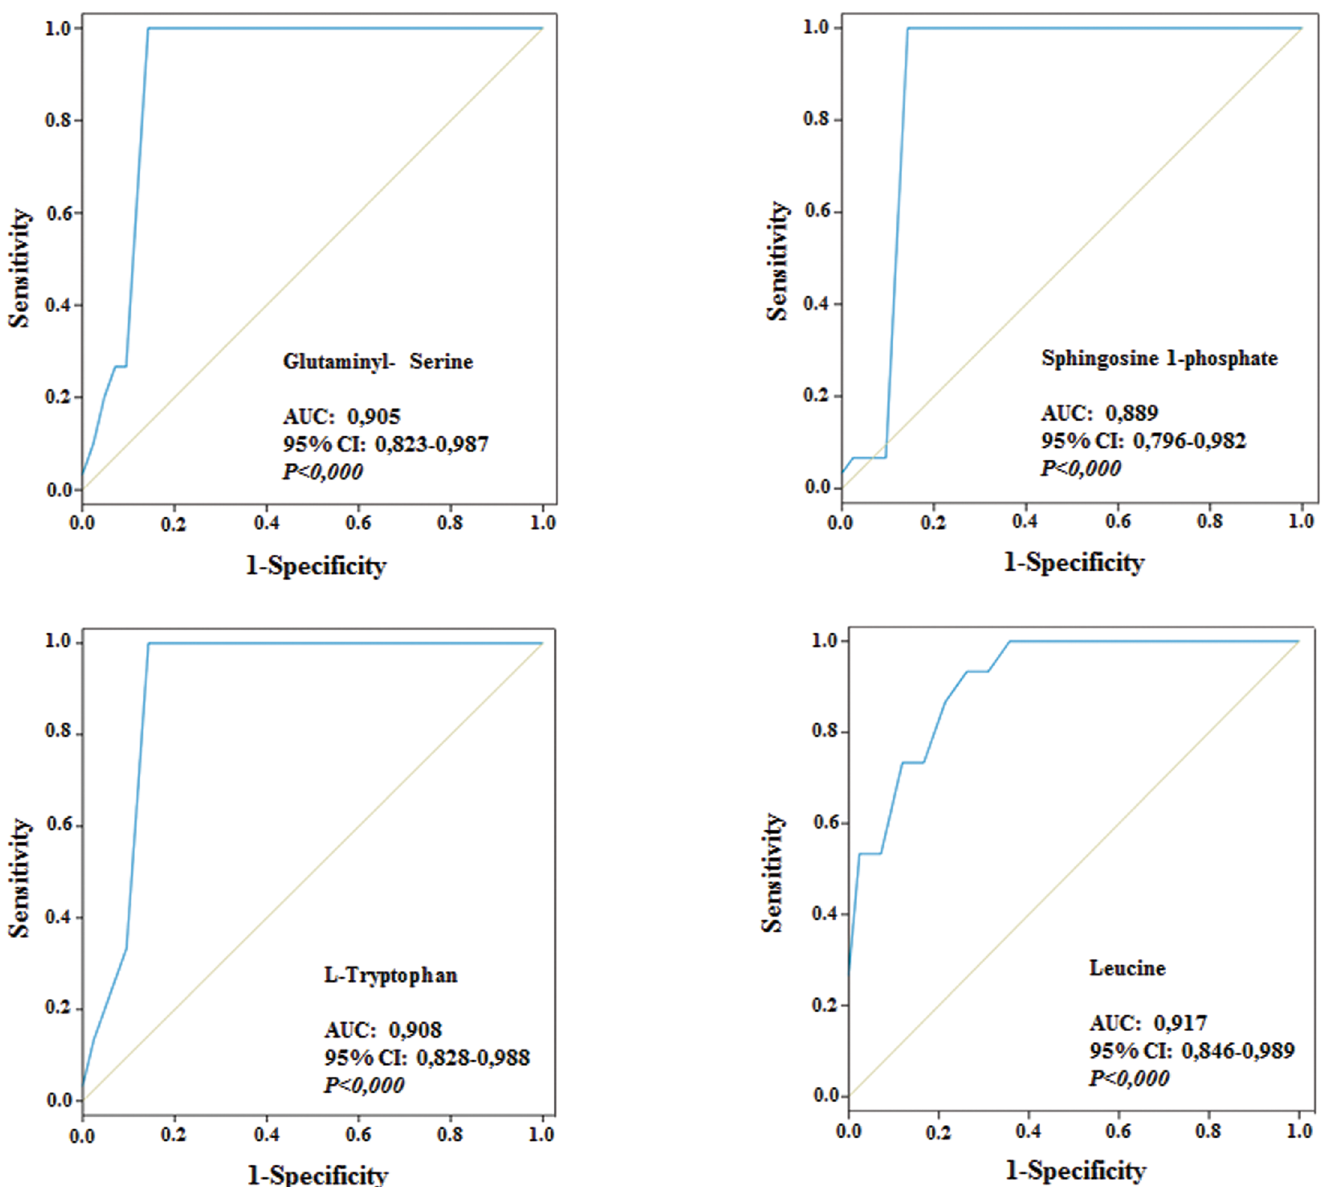
Fig 5. Diagnostic performance of metabolic biomarkers. ROC curves were plotted to describe performance characteristics of the indicated metabolites in the 57 subject cohort. The Area under the curve (AUC), 95% range of the intervalof confidence(IC) and P values are indicated.